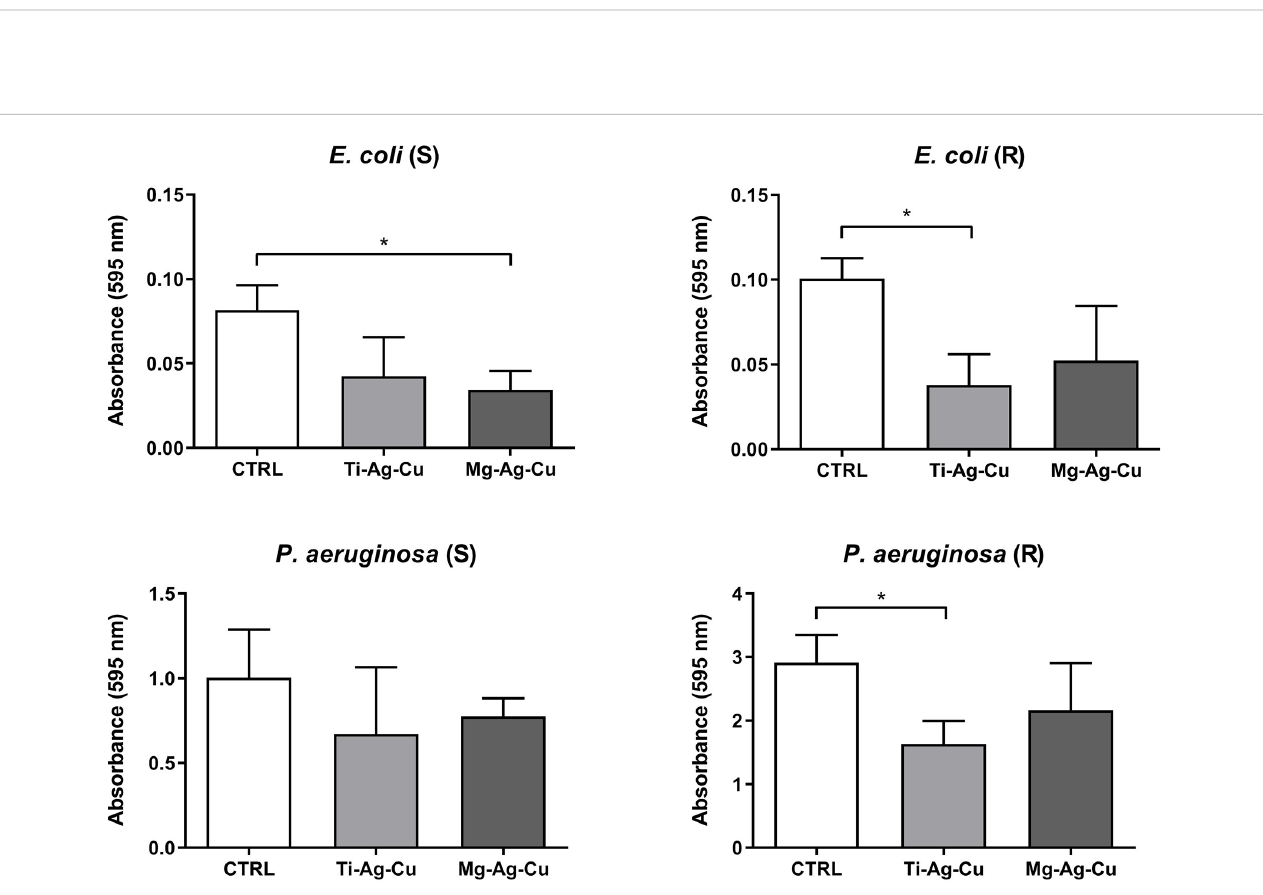
FIGURE 6 Effect of Ti-Ag-Cu and Mg-Ag-Cu coating on E. coli (S and R) and P. aeruginosa (S and R) bio fi lm compared to uncoated glass discs (CTRL) analyzed by means of the spectrophotometric crystal violet assay. Statistical signi fi cance: p < 0.05 (*).